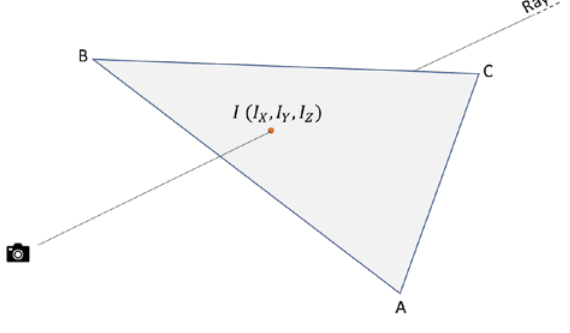
Figure 2. 2D raycast system.